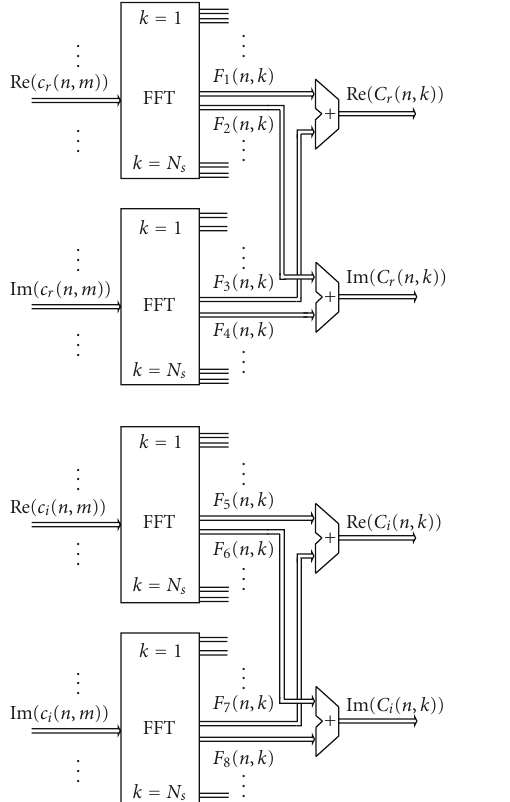
Figure 7: Architecture for realization of C r ( n , k ) and C i ( n , k ) functions.